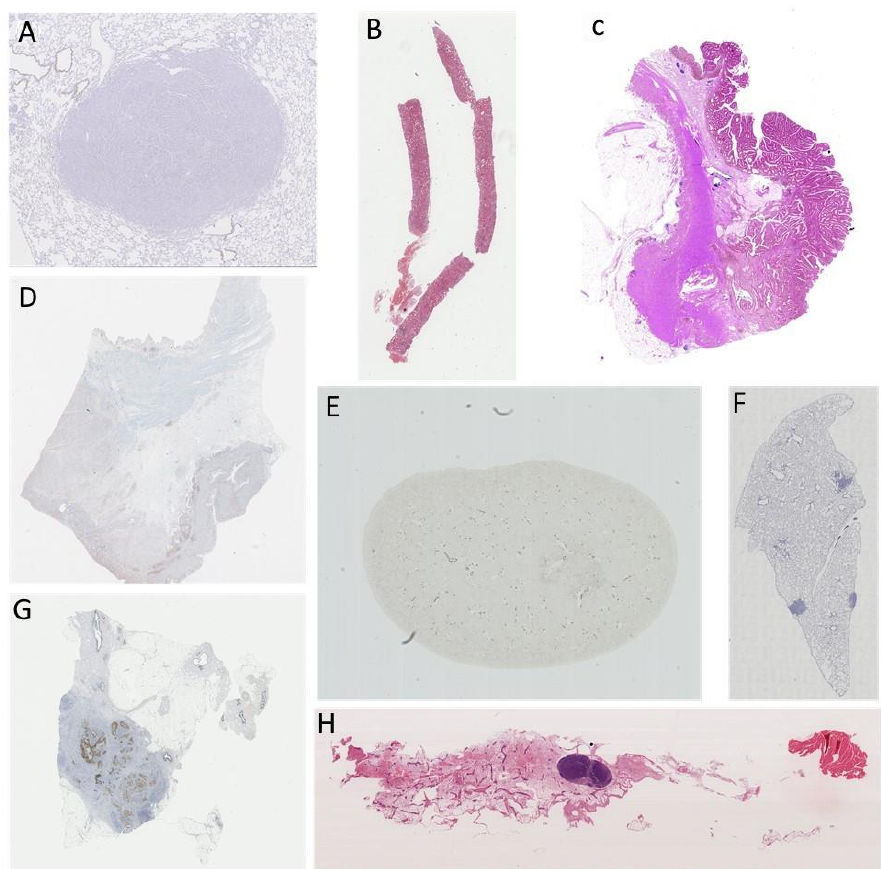
Figure 2. Example histologic images from the various anatomical sites included in the ANHIR dataset, i.e., ( A ) lung lesion, ( B ) kidney, ( C ) colon adenocarcinoma, ( D ) gastric, ( E ) mice kidney, ( F ) lung lobes, ( G ) breast, and ( H ) mammary gland.